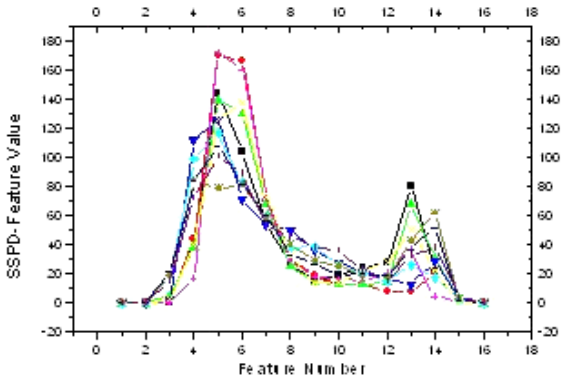
Fig. 5. The feature vector graph plotted for 10 samples of the first person in AT & T face